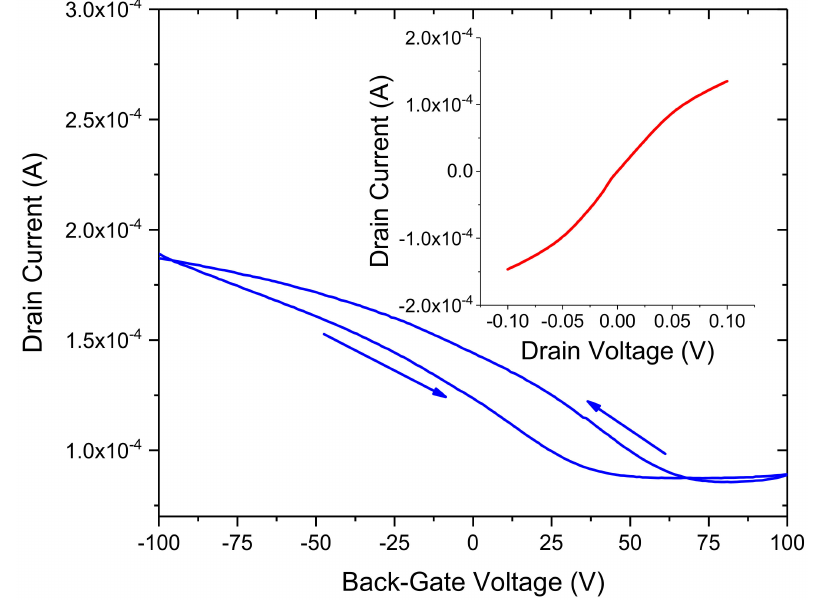
Figure 3. I D –V G at V D = 100 mV and the corresponding I D –V D (inset) of a CVD graphene FET sensor. The arrows indicate forward ( − 100 V to 100 V) and reverse (100 V to − 100 V) sweep of the back-gate voltage showing hysteretic behavior.